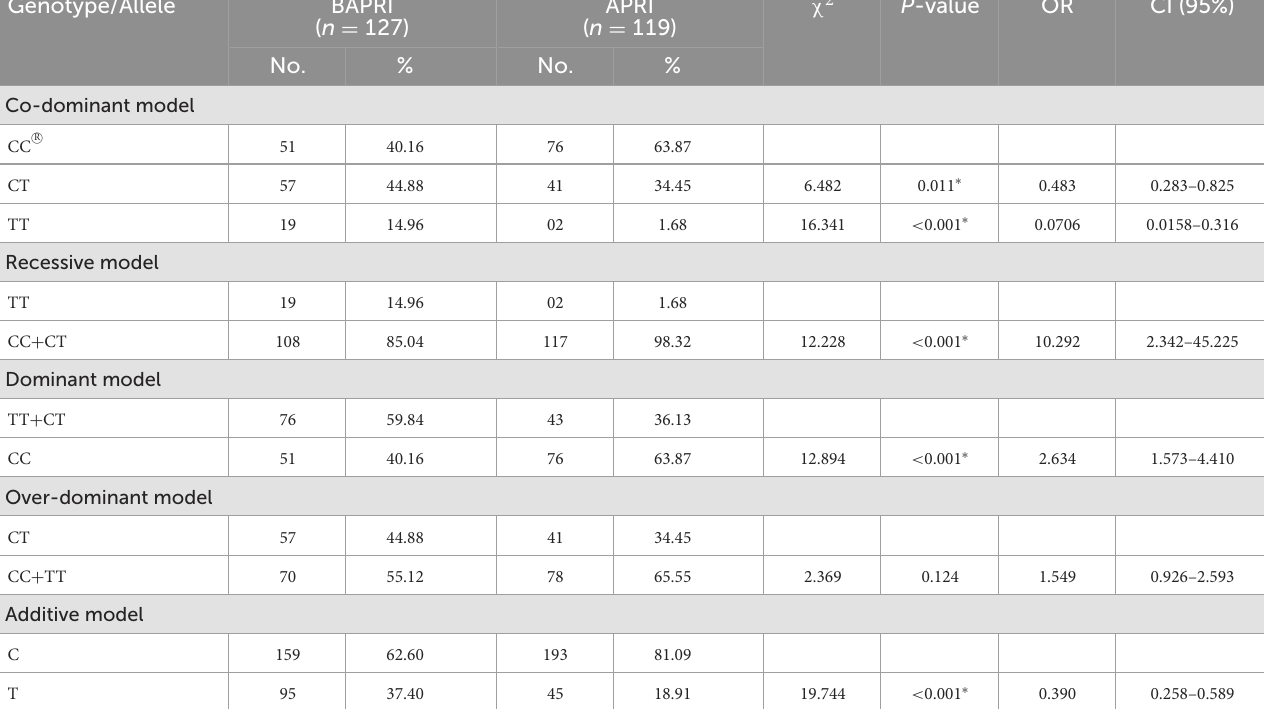
TABLE 3 BDNF gene polymorphism under co-dominant, recessive, dominant, over-dominant, and additive models in individuals below average PRI (BAPRI) and average PRI (APRI).